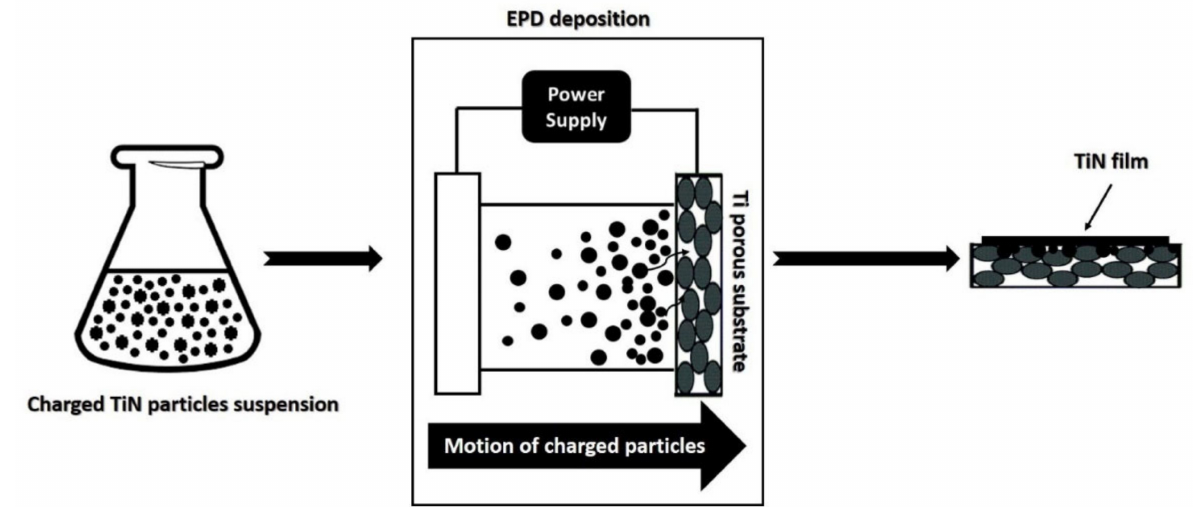
Figure 1. Flow chart of the EPD deposition process. TiN powders were infiltrated on polished porous Ti discs by applying different direct current (DC) deposition potentials: 10 V for suspensions containing micrometric powders (TiN-micro and TiN-nano/micro) and 5 V for the suspension containing only nanometric powders (TiN-nano). The distance between the electrodes was set at 1